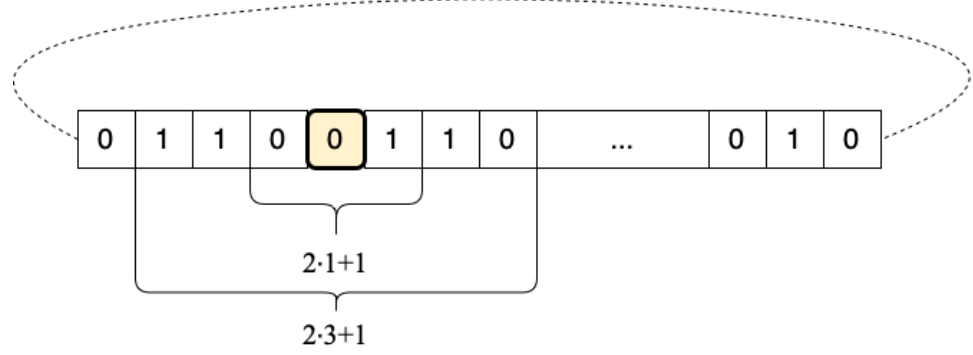
Figure 3. Neighborhoods containing 2 r + 1 cells, r = 1 and r =